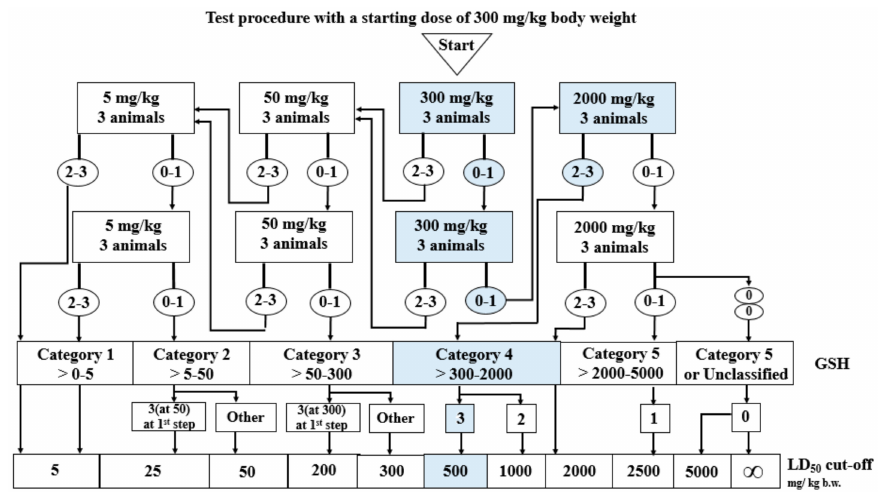
Figure 3. Stages of the in vivo acute oral toxicity studies.